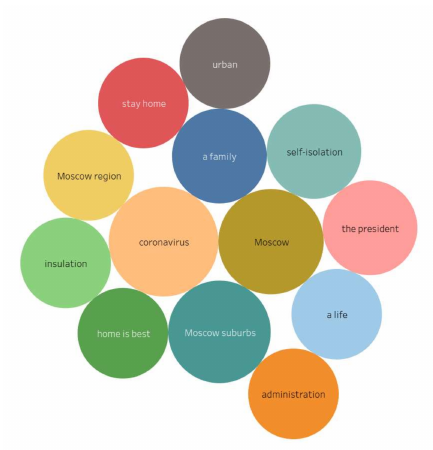
Figure 11. Associative network for stimulus authority (10/10,946, regional